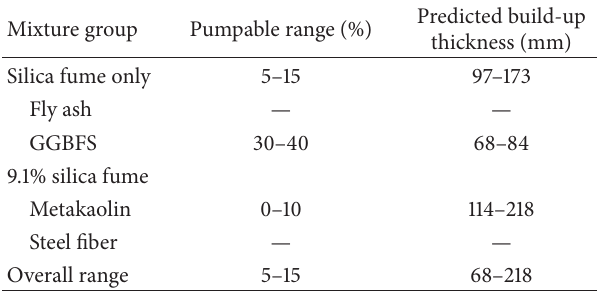
Table 3: Predicted build-up thickness ranges for WMS mixtures meeting pumping